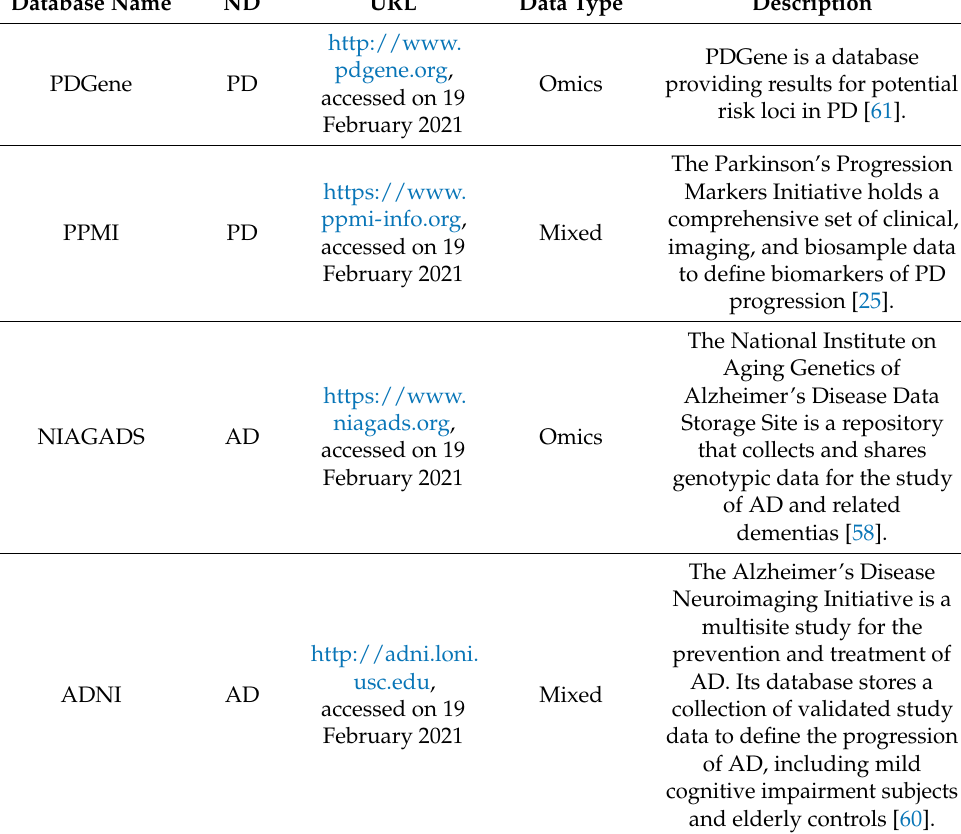
Table 2. Most representative databases, including data for ND